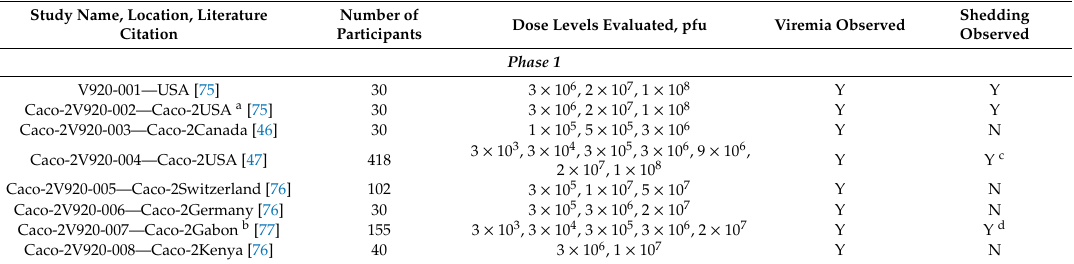
Table 2. rVSV ∆ G-ZEBOV-GP clinical trials in which viremia and viral shedding / excretion were evaluated and which were included in the ERA.